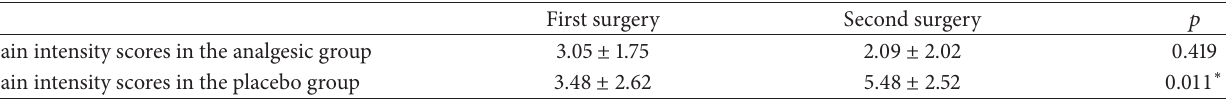
Table 2: Comparison of pain scores (NRS-11) between patients who received the analgesic drug in the first surgery and the second surgery and between patients who received the placebo in the first surgery and the second surgery.